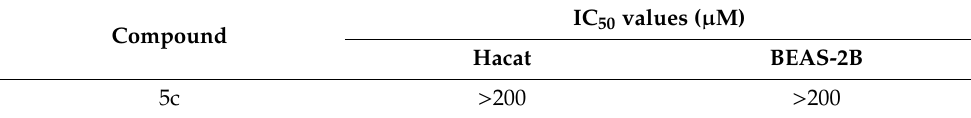
Table 2. IC 50 values ( µ M) of compound 5c against human normal cell